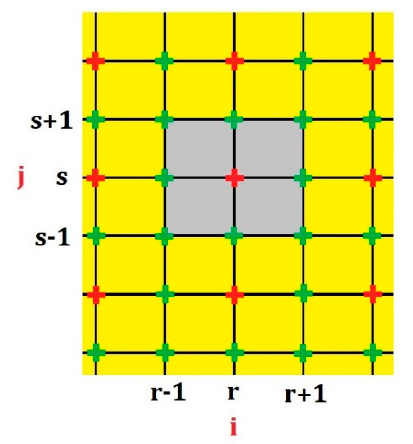
Figure 4. Arrangement of the calculation grid nodes G rs and the lattice cells C ij . The green crosses represent the grid nodes, and the red crosses indicate the centers of the lattice cells. In gray, we show the cell C ij .